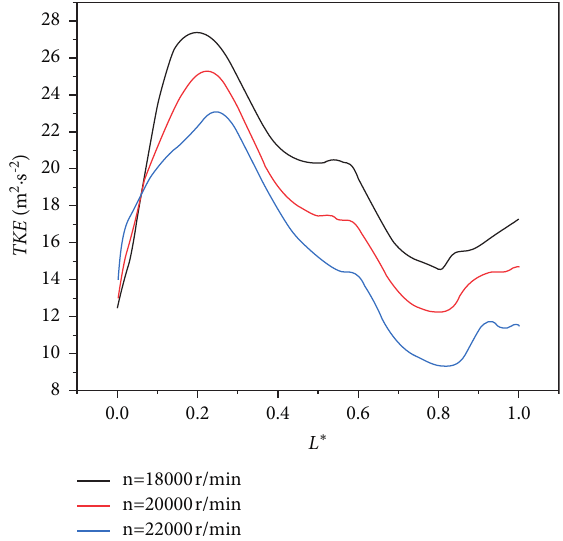
Figure 15: TKE distribution of the impeller blade.